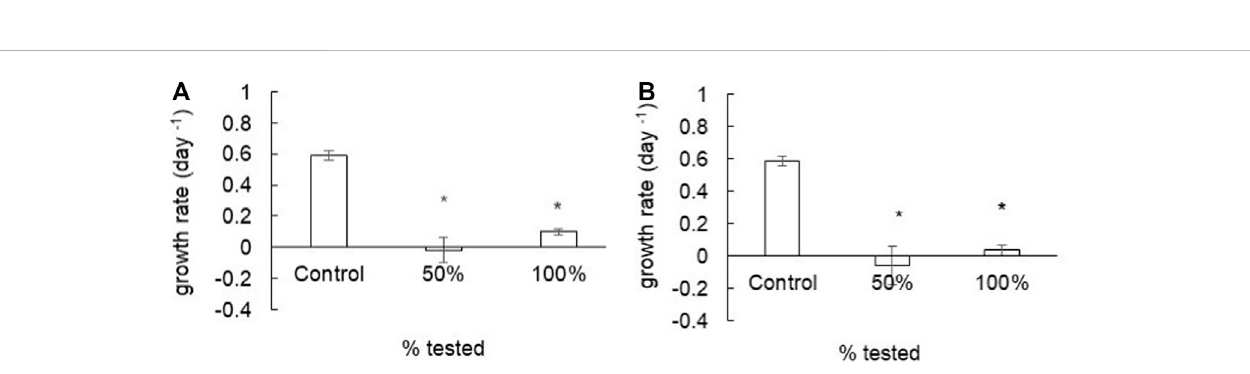
FIGURE 9 Mean algal growth rate after treatment with Ag@ACF-treated water. In (A) water treated for 2 h and (B) water treated for 24 h. Data were analyzed using ANOVA, followed by Tukey ’ s post-hoc test (* p <